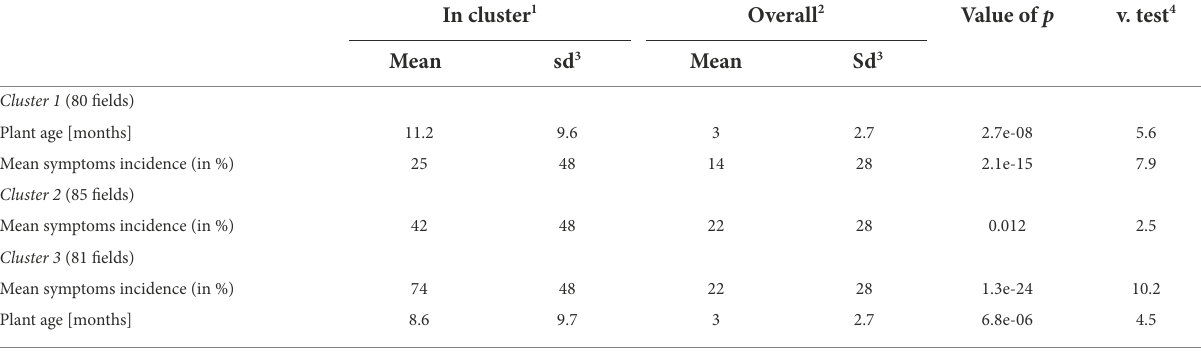
TABLE 4 Continuous (quantitative) variables associated with the description of clusters from HCPC analysis.